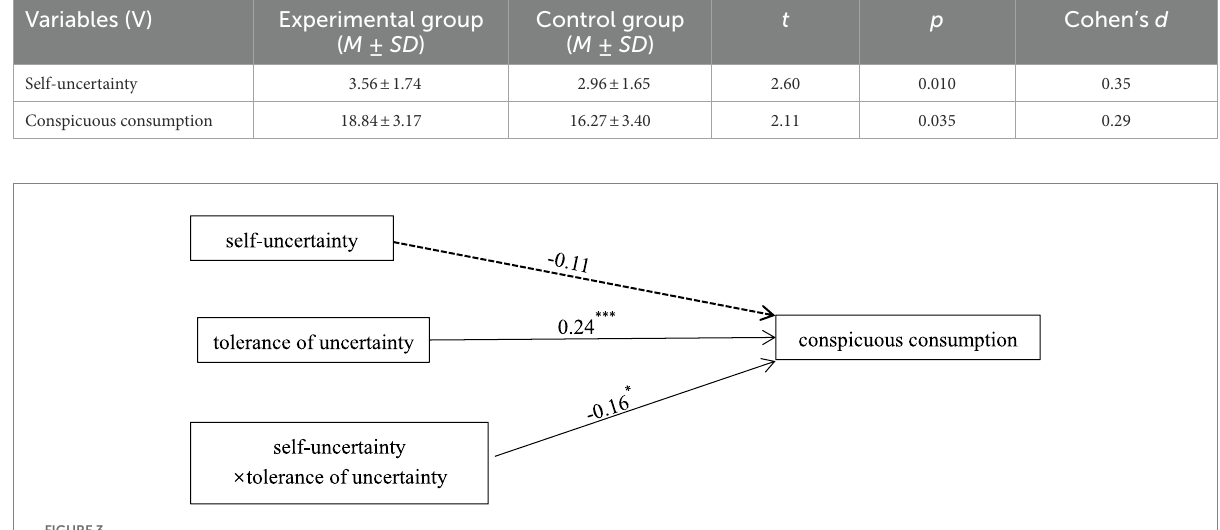
FIGURE 3 Statistical model of the moderating effect of tolerance of uncertainty. The solid line in the graph indicates that p < 0.05; the dashed line indicates that * p < 0.05; ** p < 0.01; *** p <